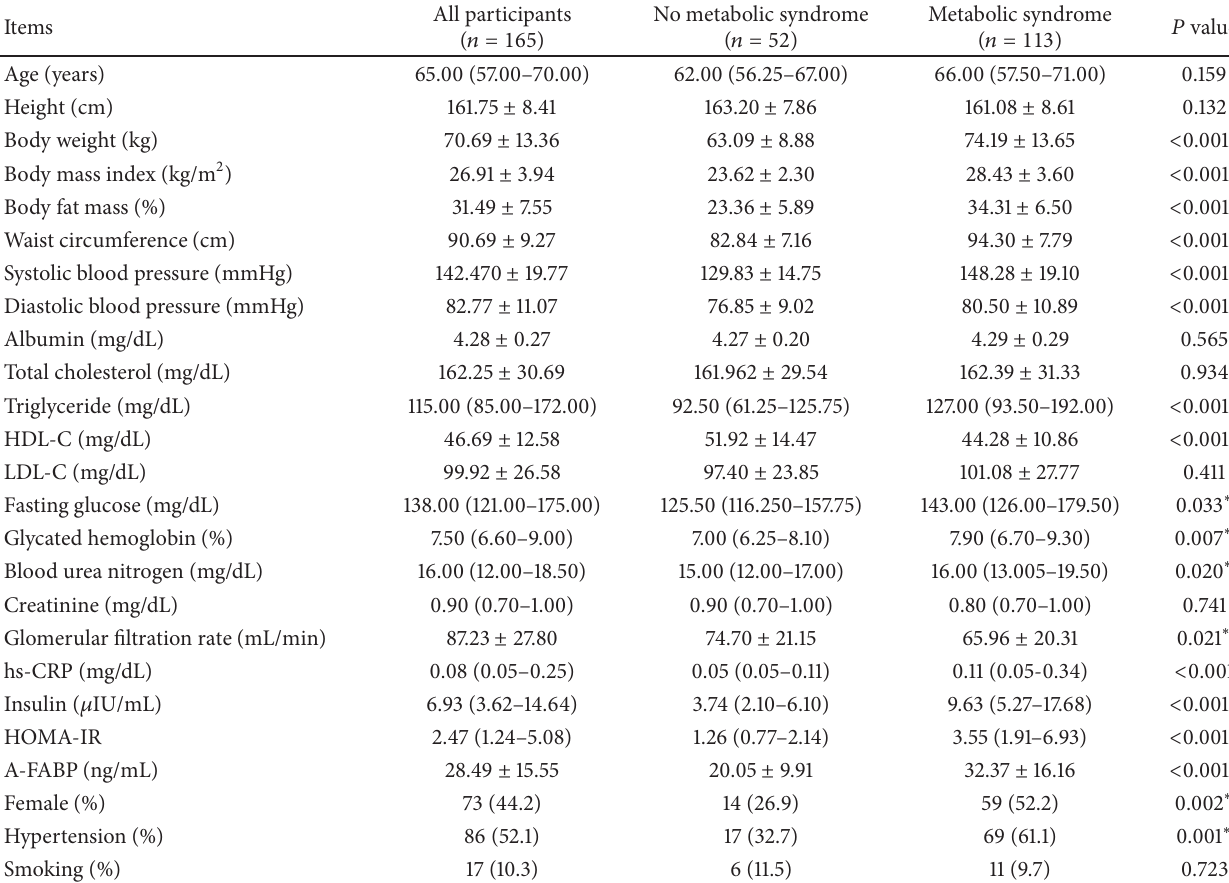
Table 1: Clinical variables of the 165 diabetic patients with or without metabolic